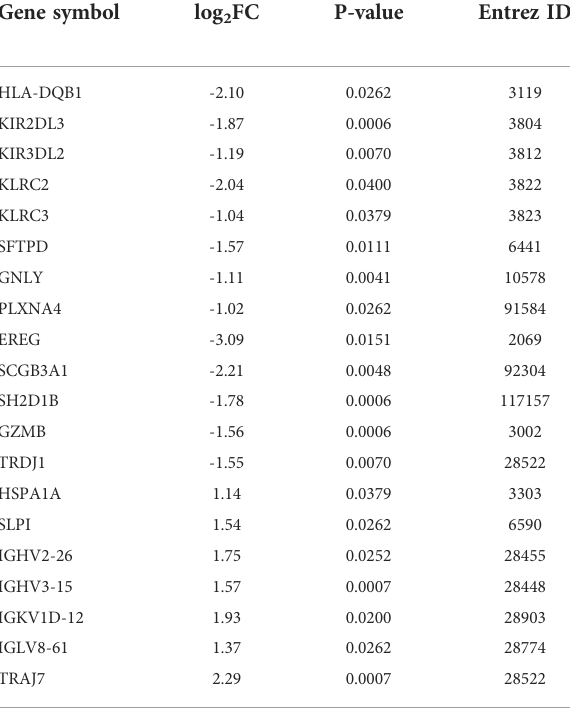
TABLE 1 Immune differentially expressed genes of Vogt-Koyanagi- Harada